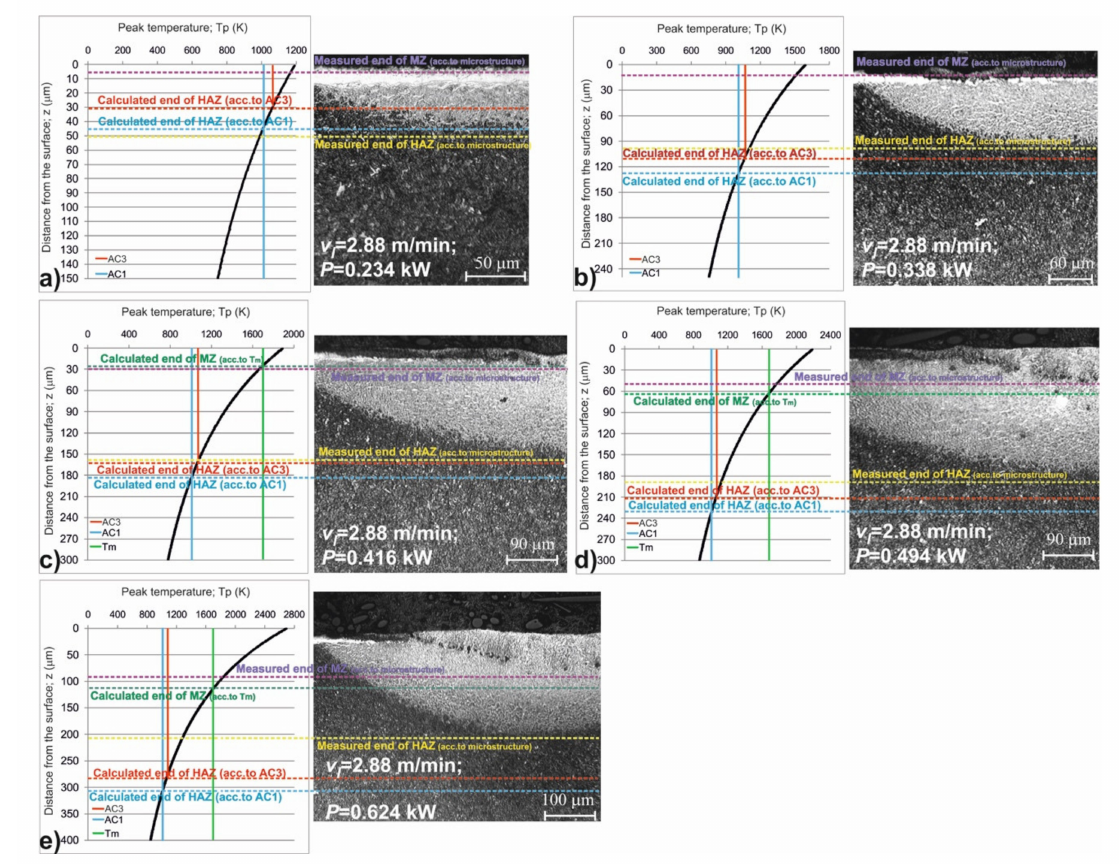
Figure 6. Temperature distribution along the axes of laser tracks and related microstructures after laser modification of gas-nitrided layer using scanning rate v l = 2.88 m · min − 1 and laser beam power as follows: P = 0.234 kW ( a ); P = 0.338 kW ( b ); P = 0.416 kW ( c ); P = 0.494 kW ( d ); and P = 0.624 kW ( e